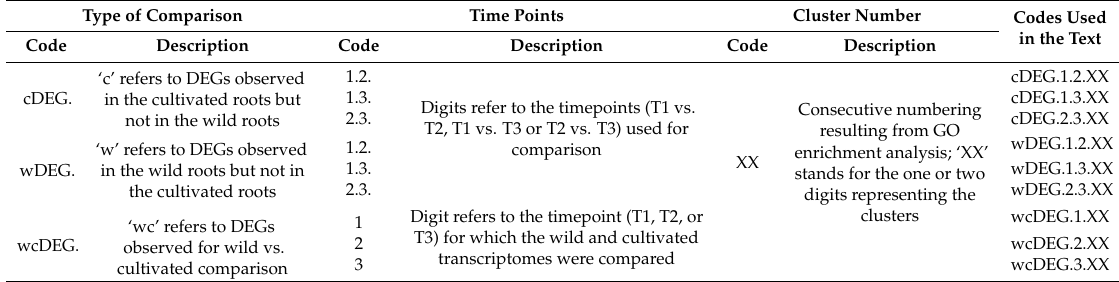
Table 1. Description of the method used to label the reported comparisons and DEG clusters. GO—gene